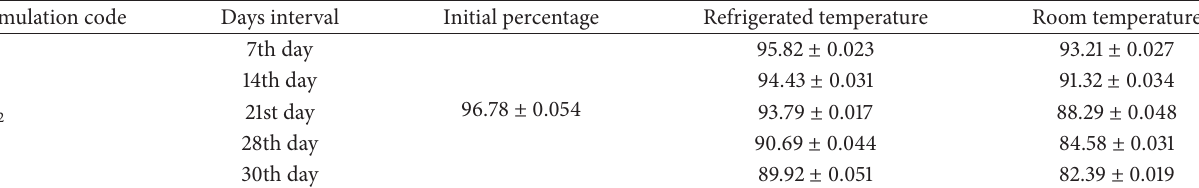
Table 5: Effect of storage on percentage residual content at refrigerated and room temperature.